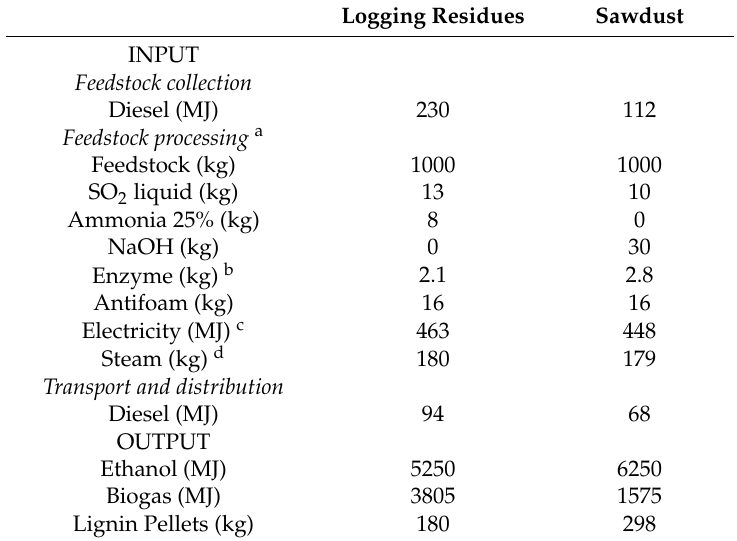
Table A1. Life cycle inventory of ethanol production from 1000 kg feedstock [24,31,32].